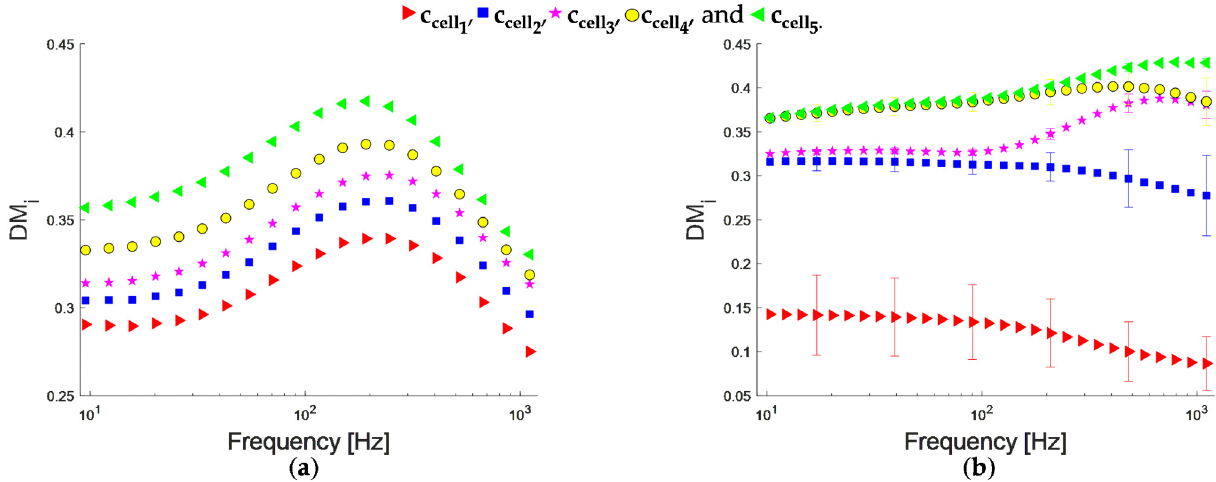
Figure 6. DM i of ( a ) K-562 cells and ( b ) leukocytes suspended in RPMI-1640 supplemented. Concen- trations are represented by the symbols.